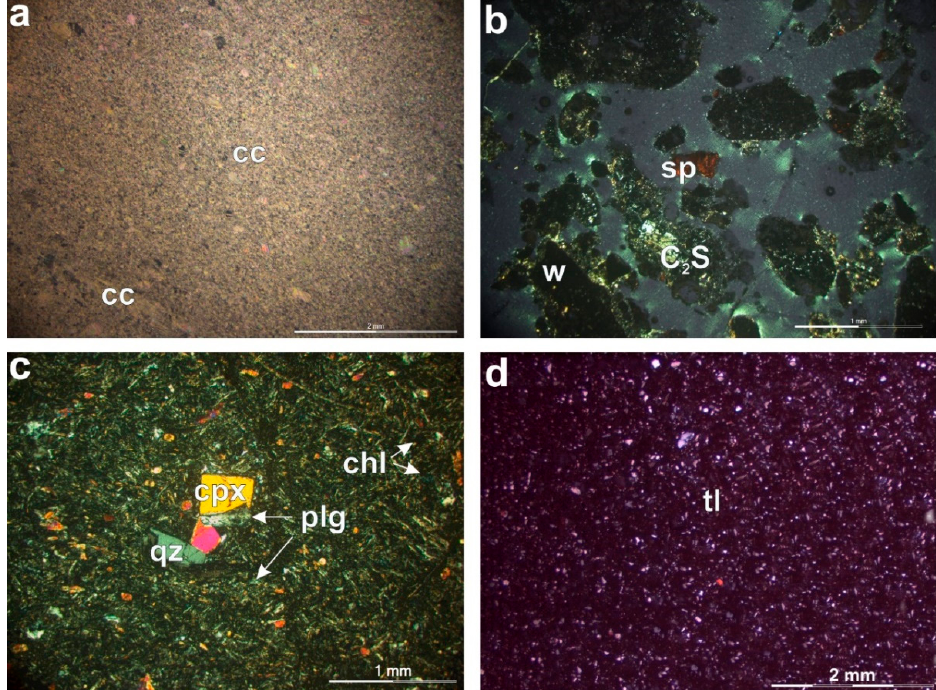
Figure 3. Representative photomicrographs of the studied raw materials: ( a ) microcrystalline calcite (cc) in fossil limestone (sample S1A, XPL); ( b ) grains of wüstite (w), spinel (sp), and calc ‐ aluminosilicate phases (C 2 S) in slag (sample S3A, XPL); ( c ) porphyritic and microlitic textures with clinopyroxene (cpx) and plagioclase (plg) in basalt surrounded by chlorite (chl) and quartz (qz) (sample S2B, XPL); ( d ) optically inactive groundmass (black) with quartz inclusions (qz) in tile (sample S4A,